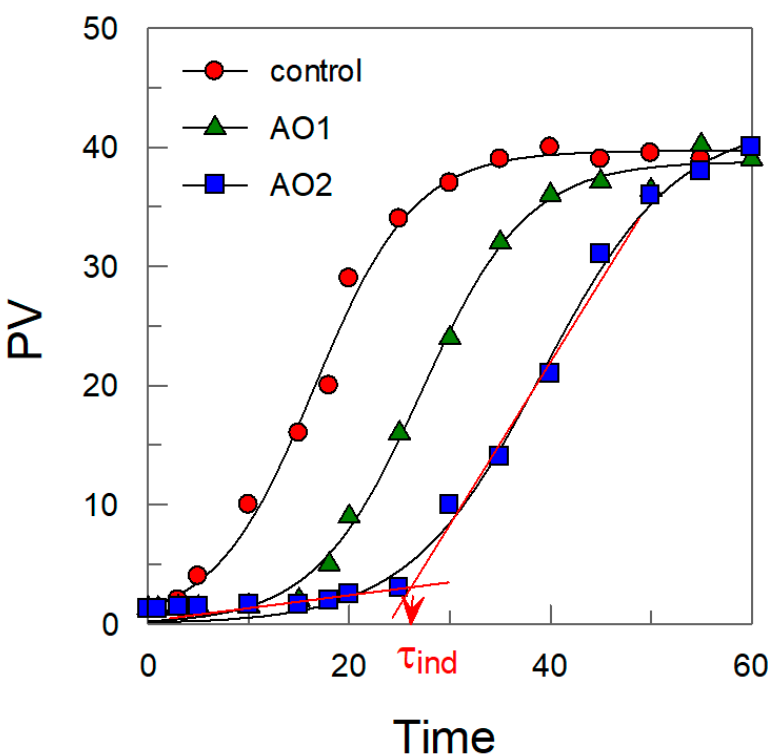
Figure 2. Illustrative plot of the kinetics of production of peroxidation products (PV) in the absence (control) and in the presence of two hypothetical antioxidants AO1 and AO2 under the same experimental conditions and determination of the induction time τ IND . Both PV values and time are given in arbitrary units. Solid lines drawn to aid the eye.